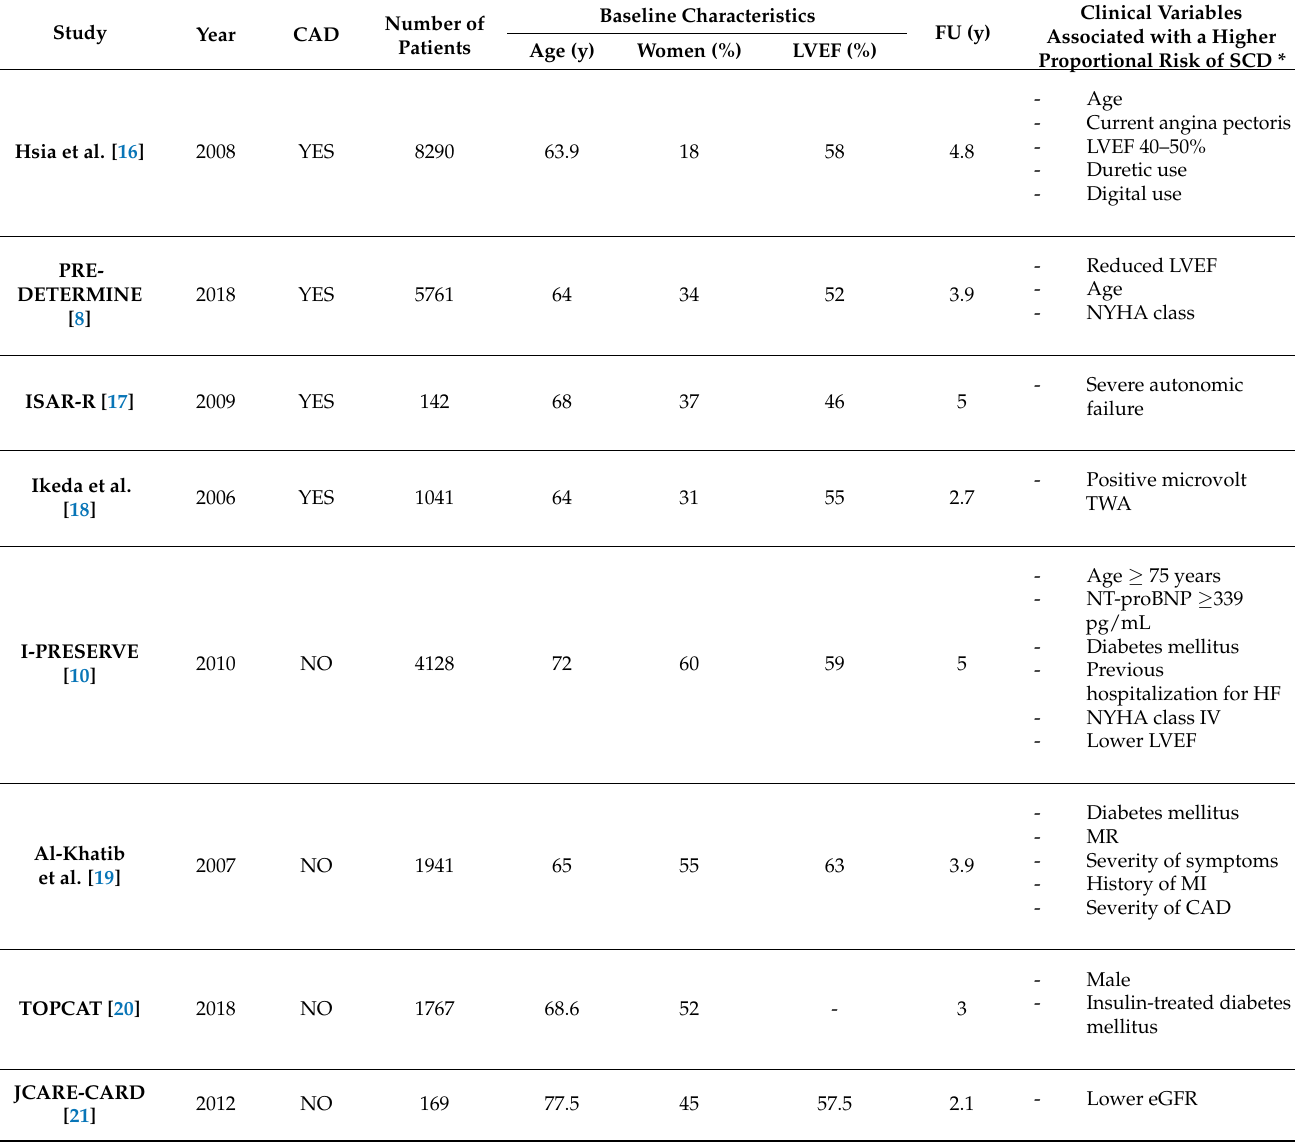
Table 1. Studies evaluating the relationship between left ventricular ejection fraction and sudden cardiac death. Baseline Characteristics Clinical Variables Study Number of Associated with a Patients